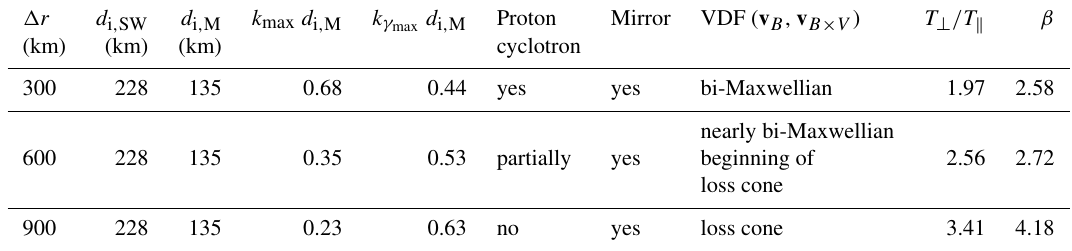
Table 1. Summary table for each run with spatial resolutions, the inertial length d i , SW in the solar wind, the inertial length d i , M in the mag- netosheath, the maximum wave vector allowed by the simulation ( k max = π/(cid:49)r ), the wave vector at which the proton cyclotron instability’s growth rate is maximum ( k γ ), status of the proton cyclotron and mirror instabilities in the simulation, VDF shapes in the ( v B , v B × V ) max plane (Fig. 8b, f and j), temperature anisotropy, and plasma β taken at the location indicated in Fig. 1 averaged over the time range used in this